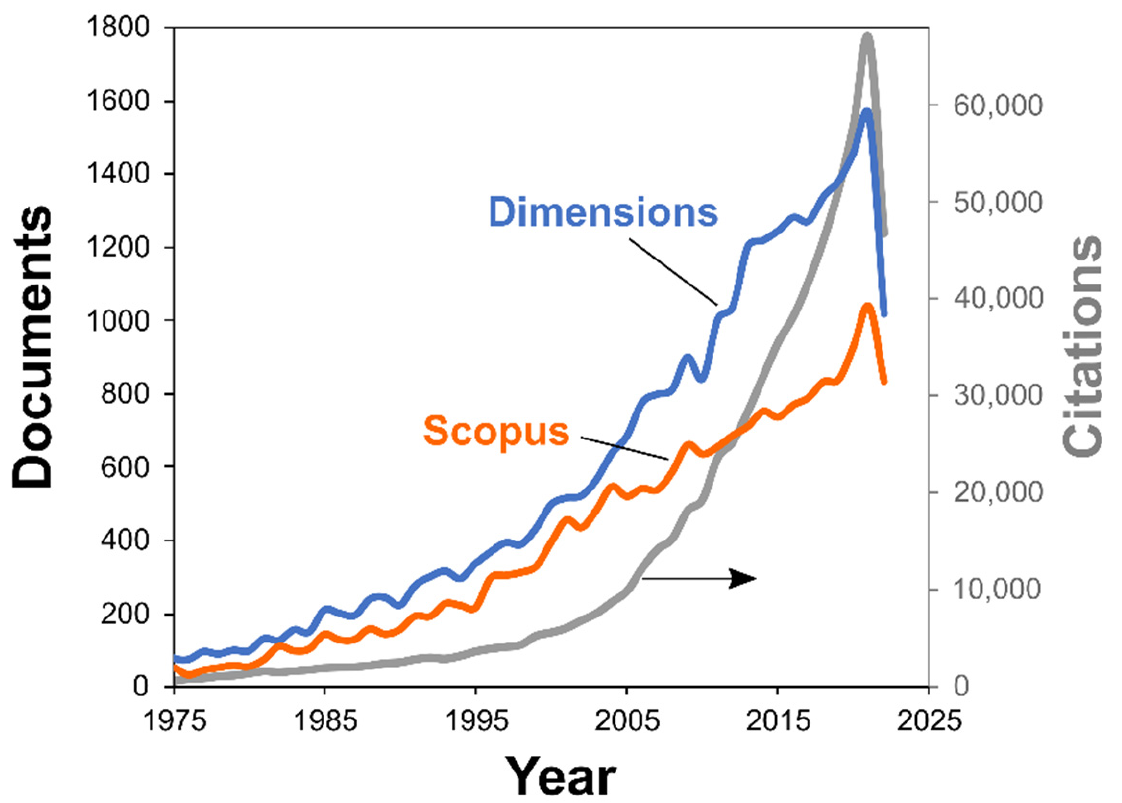
Figure 1. Number of thermokinetic papers by year: Scopus and Dimensions databases. Citations number is shown in the right axis (gray curve, Dimensions database data).